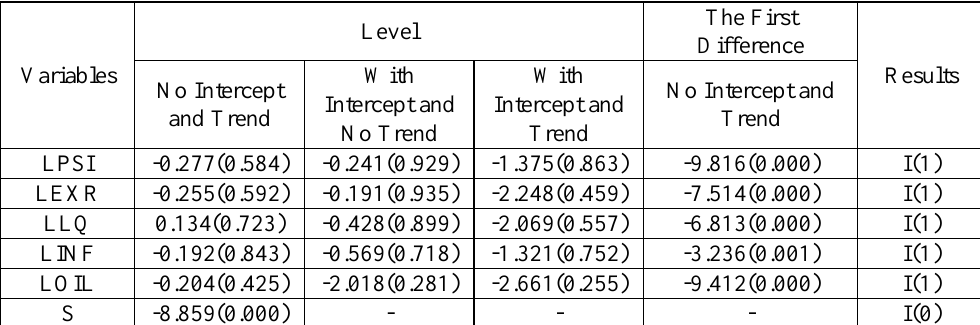
Table 1. Unit Root Test